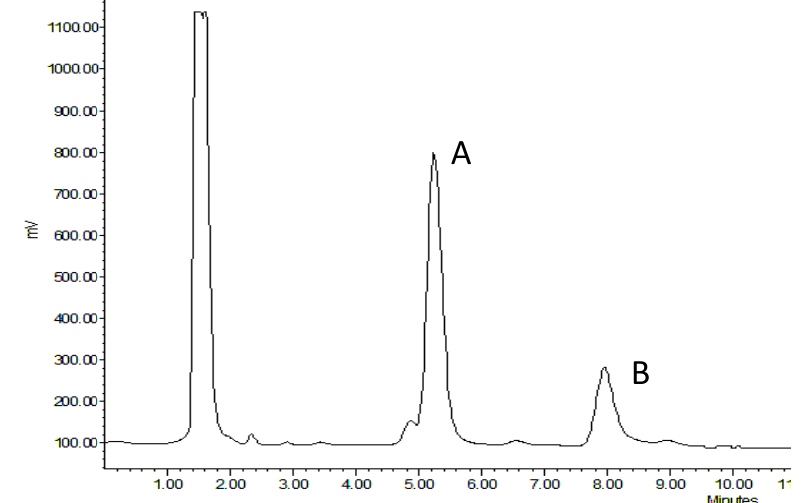
Figure 2. A representative high-performance liquid chromatography (HPLC) chromatogram of Capsicum annuum cultivar Colorado State University (CSU) 256 green showing baseline separation of ( A ) capsaicin, and ( B ) dihydrocapsaicin using Waters, Nova-Pak C18 column using fluorescence detector. Peaks were identified by comparing retention times to those of standard compounds (capsaicin and dihydrocapsaicin).